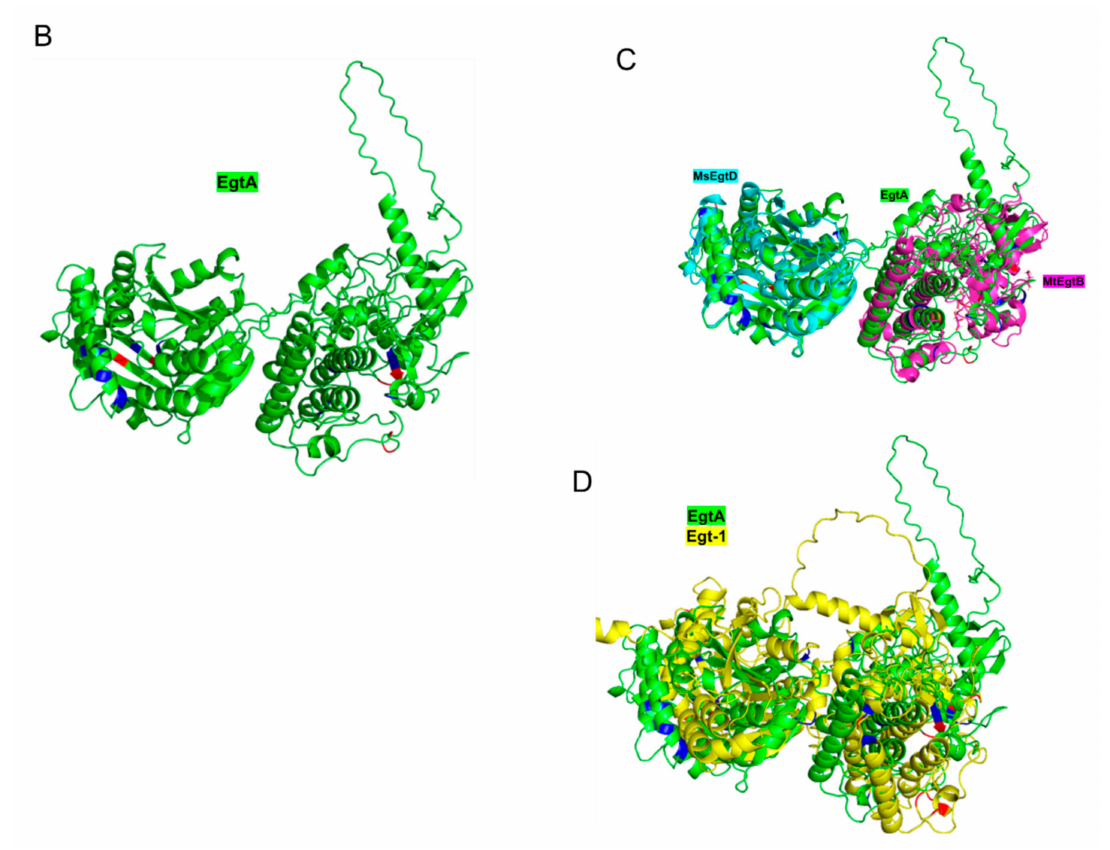
Figure 6. ( A ) Sequence alignment of bacterial and fungal ergothioneine biosynthetic enzymes, showing relevant active site amino acids (red boxes); ( B ) AlphaFold prediction of A. fumigatus EgtA 3D structure showing the bidomain enzyme arrangement, with active sites on opposing sites of the monomer (green); ( C ) MsEgtD methyltransferase (magenta) and MtEgtB sulphoxide synthase (pink), respectively, overlaid on A. fumigatus EgtA 3D structure; ( D ) the 3D structure of NcEgt-1 (yellow), predicted by AlphaFold, overlaid on the A. fumigatus EgtA 3D structure. Table 1. Pairwise structural alignments of various Egt protein structures. Comparison TM-score SI%